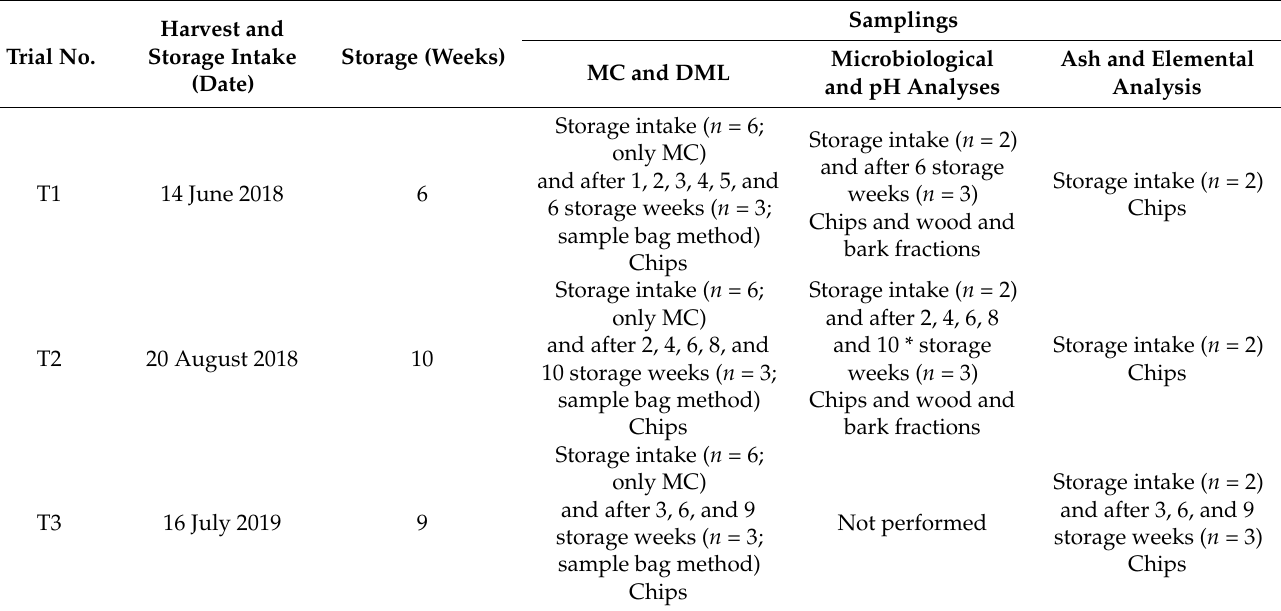
Table 1. Storage trials T1–T3 and the corresponding